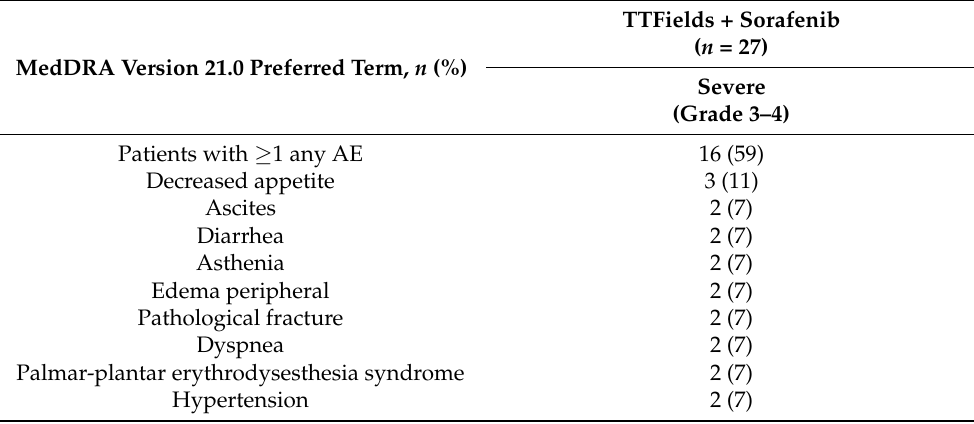
Table 5. Severe (grade 3–4) AEs occurring in >5% of patients treated with TTFields (150 kHz) concomitant with